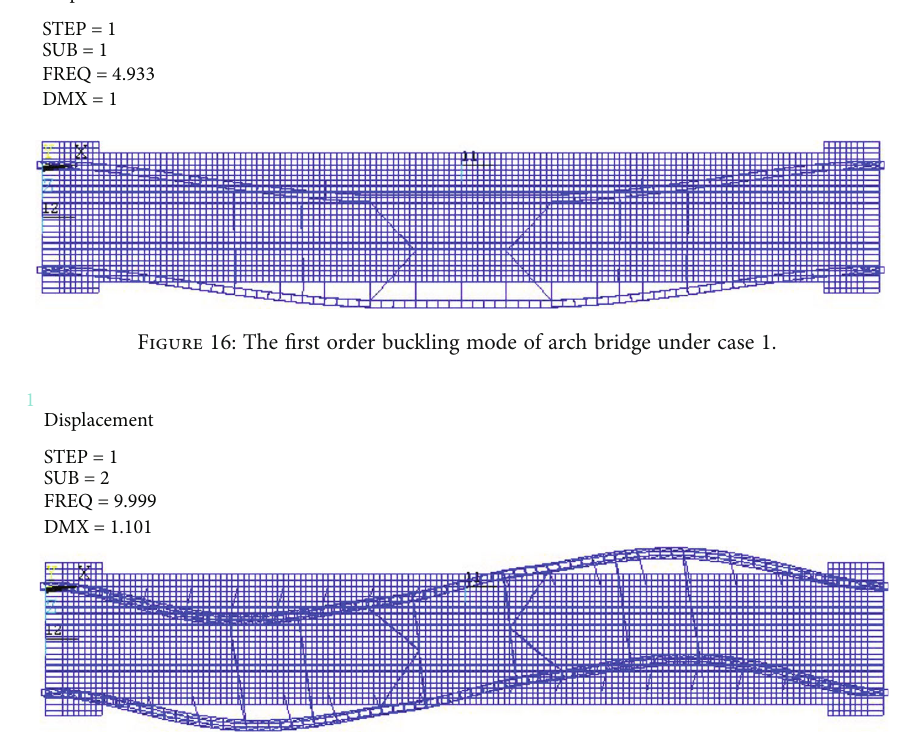
Figure 17: The second order buckling mode of arch bridge under case